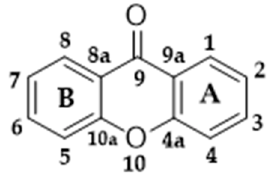
Figure 5. Xanthones with antibacterial activity isolated from plants in Brazil. 3,4-dihydroxy-2-meth- oxyxanthone ( 21 ), 5-hydroxy-1,3-dimethoxyxanthone ( 22 ), 4-hydroxy-2,3-dimethoxyxanthone ( 23 ), 3-hydroxy-2-methoxyxanthone ( 24 ), 2-hydroxy-1-methoxyxanthone ( 25 ), Assiguxanthone B ( 26 ), 1,3,7 ′ trihydroxy-2-(3-methylbut-2-enyl)-xanthone ( 27 ), 8-carboxymethyl-1,3,5,6-tetrahydroxyxan- thone ( 28 ), 1,5-dihydroxyxantona ( 29 ) . The prenylated xanthone 1,3,7 ′ trihydroxy-2-(3-methylbut-2-enyl)-xanthone ( 27 ) (Fig- ure 5) isolated from Kielmeyera coriacea species proved to be a potent inhibitor against the Gram-positive bacteria S. aureus (ATCC 25923) and B. subtilis (ATCC 6623), exhibiting a